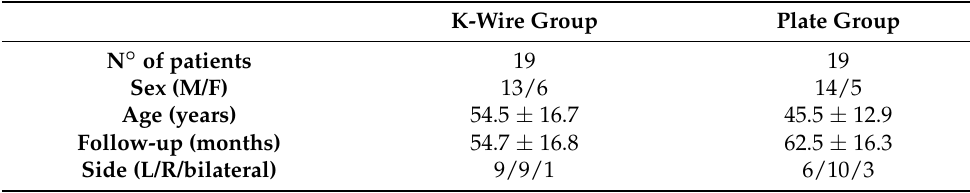
Figure 3. Extended approach and dedicated plate. ( A ) Pre ‐ operative radiographs; ( B ) pre ‐ operative CT scan in coronal and sagittal plane showing a Sanders III CF; ( C ) post ‐ operative radiographs at 4 ‐ year follow ‐ up. Table 1. Demographic characteristics and mean follow ‐ up of KG and PG. K ‐ Wire Group